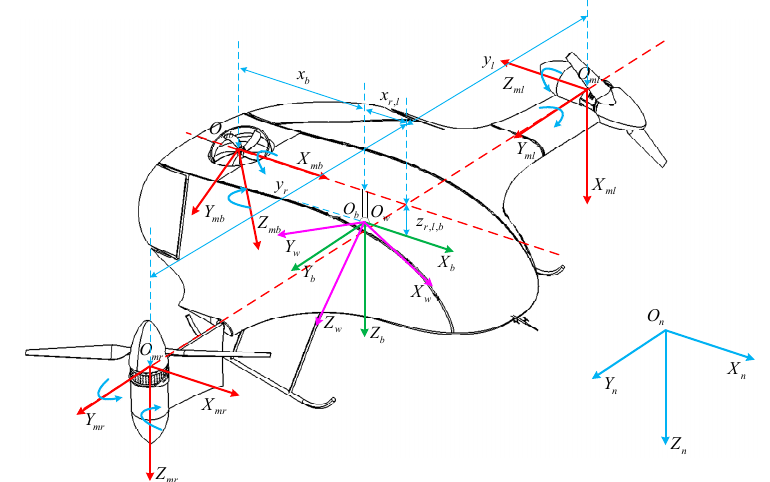
Figure 2. The schematic and frame of the novel tilt-rotor